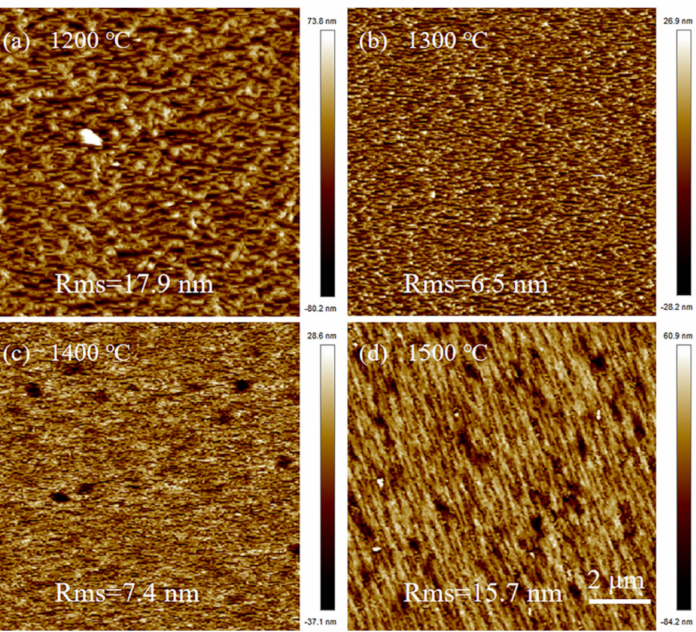
Figure 4. 10 × 10 µ m AFM image of buffer layers grown at different temperatures of ( a ) 1200 ◦ C,